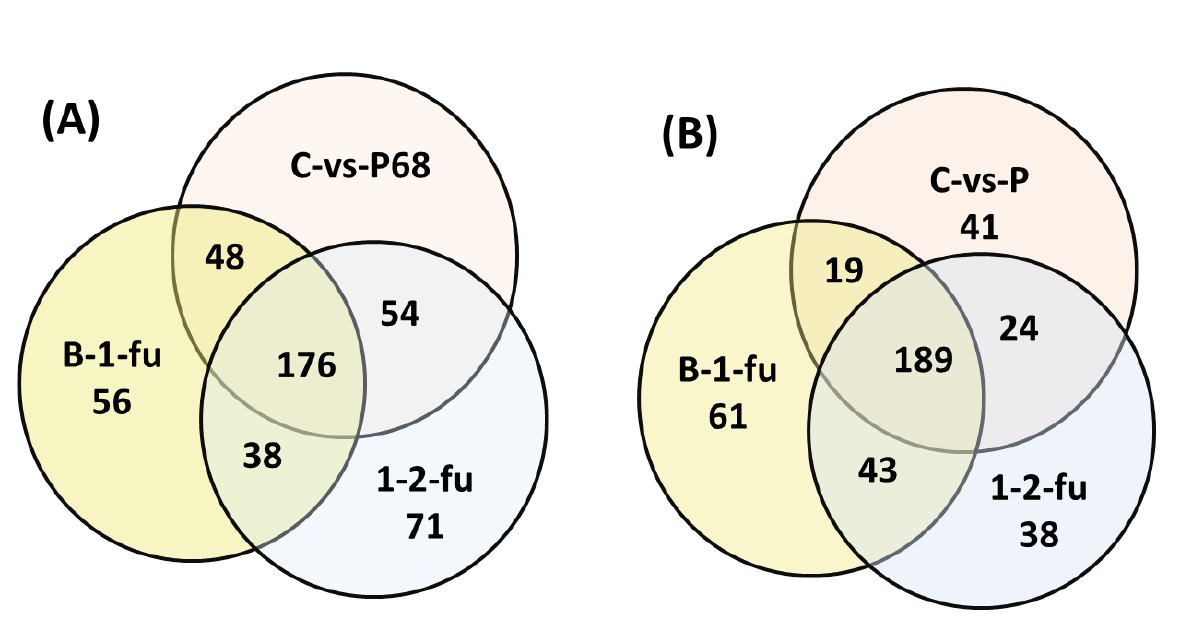
Figure 3. Venn diagram for Differentially Expressed Genes (DEGs) of MS for three stages; Control vs. Patient (C-vs-P), Baseline to the first-year follow-up (B-1-fu), and first-year follow-up to second-year follow-up (1-2-fu). ( A ) shows the Venn diagram of up-regulated and ( B ) shows the Venn diagram of down-regulated genes in the three MS